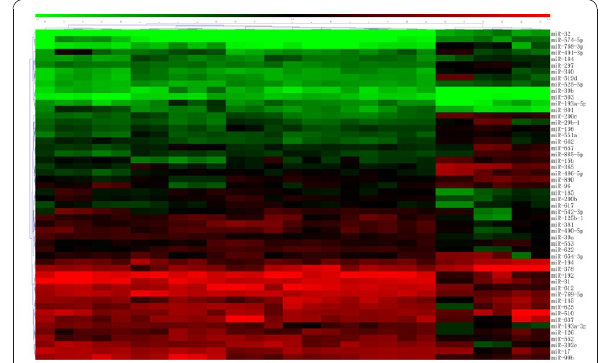
secreting pituitary adenomas: 1-21, Normal pituitary: 22-27.